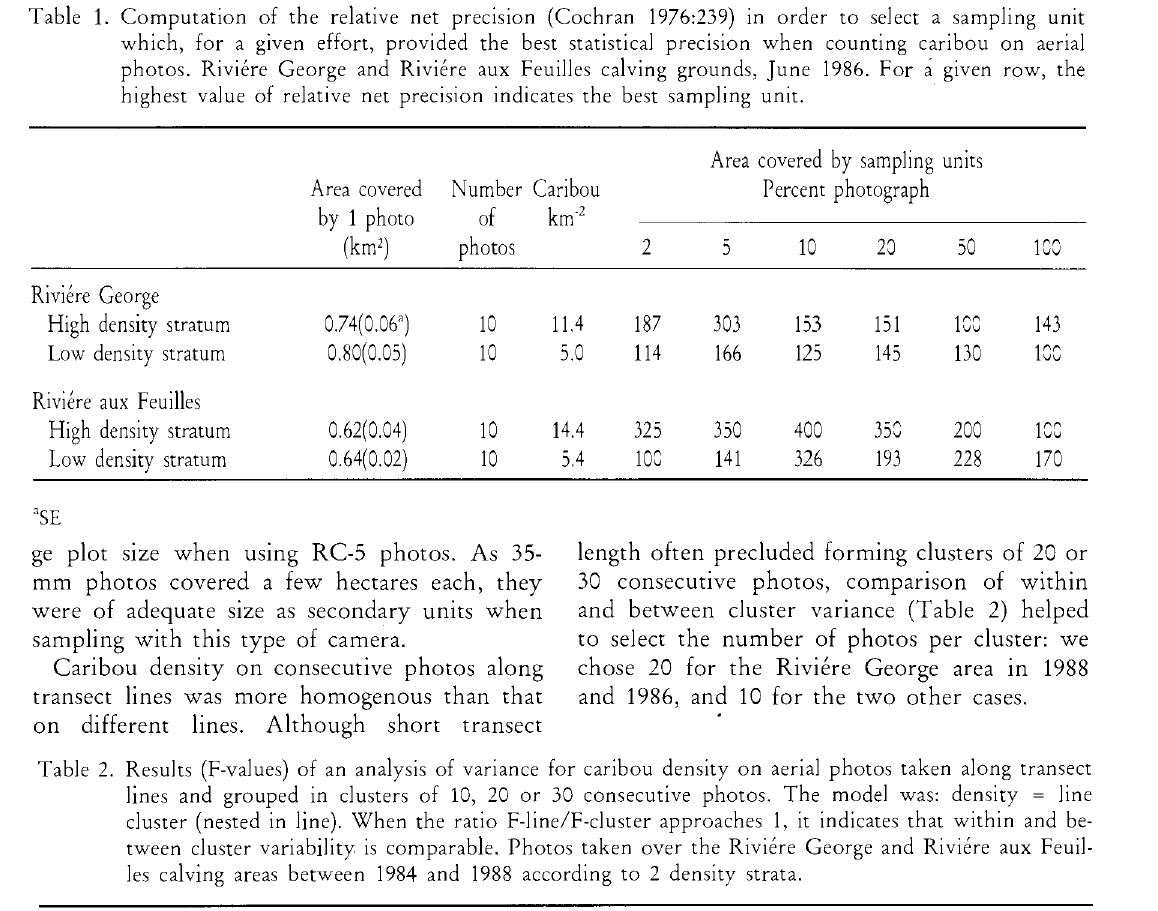
Table 1. Computation of the relative net precision (Cochran 1976:239) in order to select a sampling unit which, for a given effort, provided the best statistical precision when counting caribou on aerial photos. Riviere George and Riviere aux Feuilles calving grounds, June 1986. For a given row, the highest value of relative net precision indicates the best sampling unit.